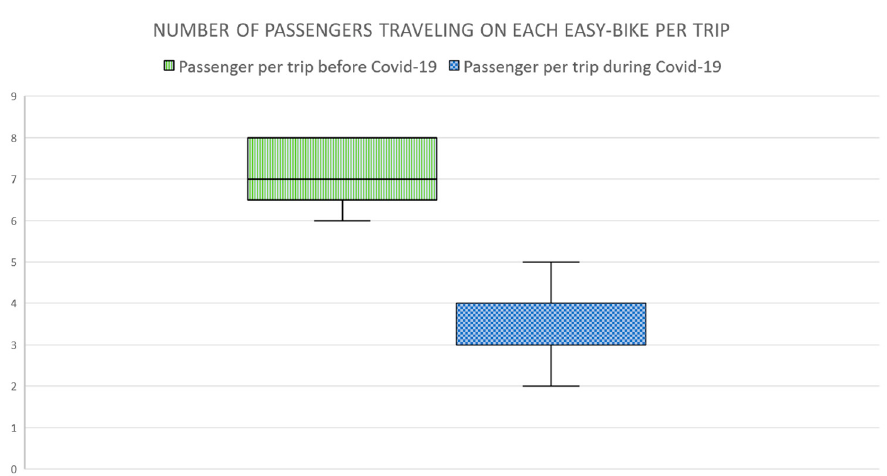
Figure 3. Number of passengers travelling on each easy-bike per trip.